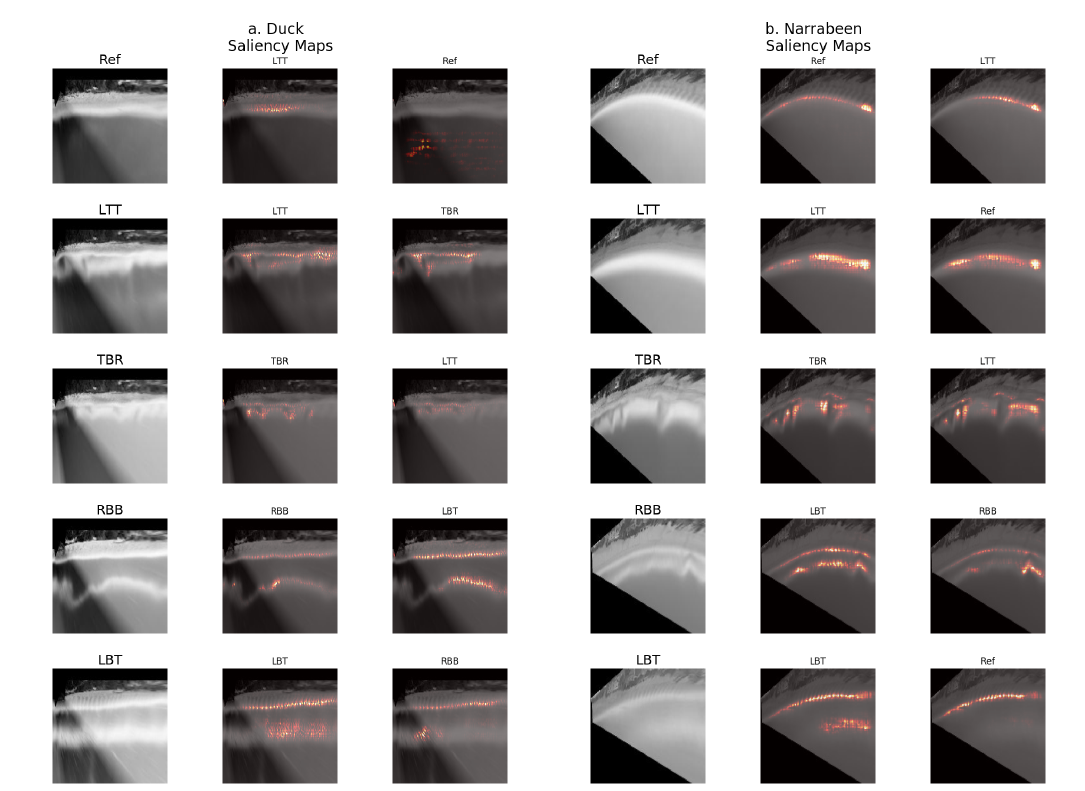
Figure 7. Saliency maps showing the pixels most relevant for classification decisions for Duck in subfigure ( a ), and Narrabeen in subfigure ( b ). The original image fed into the CNN, the first classification choice, and the second classification choice are in the first, second and third columns, respectively. The saliency maps are generated by the single-location